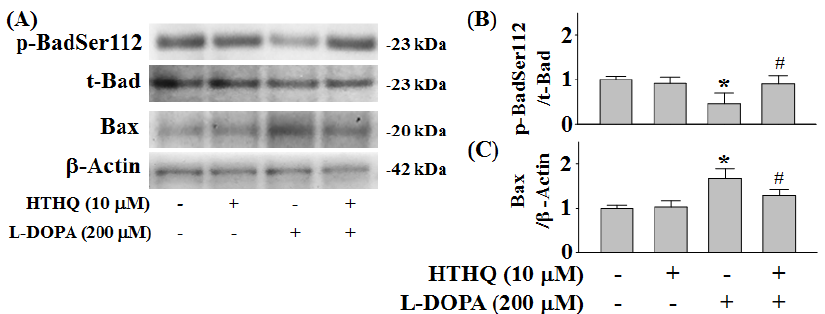
Figure 5. Effect of HTHQ on L -DOPA-induced changes in Bad phosphorylation ( A , B ) and Bax ( A , C ) expression in PC12 cells. PC12 cells were exposed to 200 µM L -DOPA (+) in the absence ( – ) or presence (+) of 10 µM HTHQ for 2 h. The values of the relative density ratios of Bad phosphorylation at Ser112 (p-BadSer112) to total Bad (t-Bad) and Bax expression to β -actin are expressed in arbitrary units. The results are expressed as the mean ± S.E.M. (n = 4). * p < 0.05 compared to L-DOPA-untreated group, # p < 0.05 compared to L-DOPA-treated group (200 μ M) (ANOVA with post-hoc Tukey’s test).